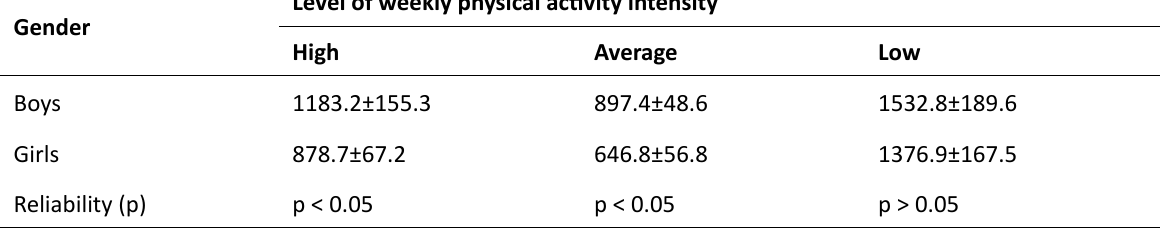
Table 3. The energy costs of students for physical activity (MET min /